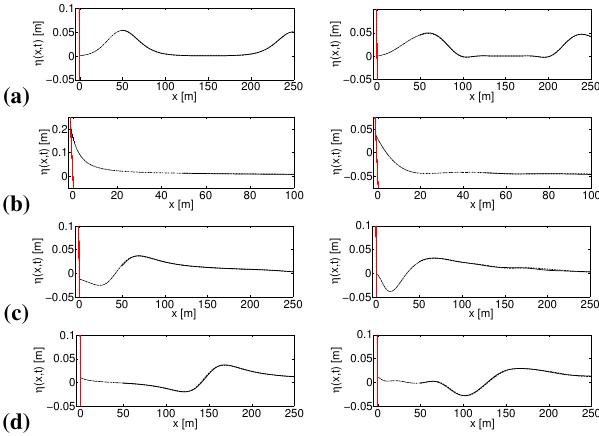
Fig. 6. Free-surface profiles of solitary wave propagation are shown Figure 6. Free-surface profiles of solitary wave propagation are for the coupled linear model (left: LSWE, right: LVBM) with the shown for the coupled linear model (left: LSWE; right: LVBM) NSWE (dashed and dotted-dashed lines), and for the linear model with the NSWE (dashed and dotted-dashed lines), and for the lin- with an EBC implementation (solid line), at times (a) t = 10 s , ear model with an EBC implementation (solid line), at times (a) t = (b) t = 20 s , (c) t = 30 s , (d) t = 40 s . The solid and dashed lines 10s, (b) t = 20s, (c) t = 30s, and (d) t = 40s. The solid and dashed are on top of another. lines are on top of one another.